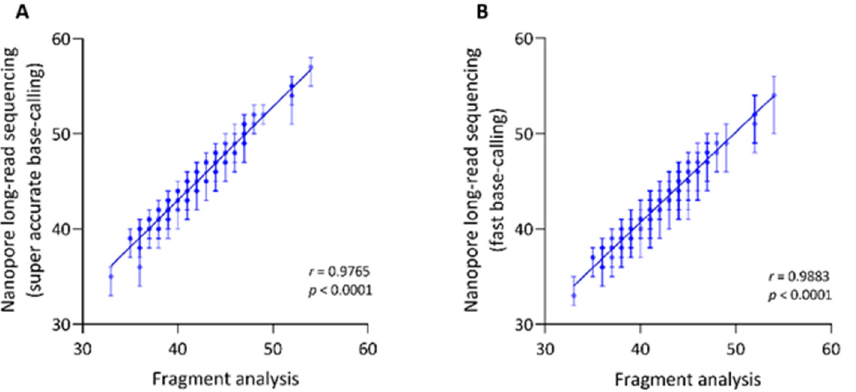
Figure 1. Repeat number detection using Nanopore long-read sequencing is highly concordant with the results from fragment analysis. Correlation between the median repeat numbers per individual of the ( CCCTCT ) n SVA domain, detected with fragment analysis and Nanopore sequencing using super accurate ( A ) or fast base-calling ( B ). Bars indicate the interquartile range of the detected repeat number with Nanopore sequencing. R = Spearman’s rank correlation coefficient, p = Spearman’s exploratory p -value.